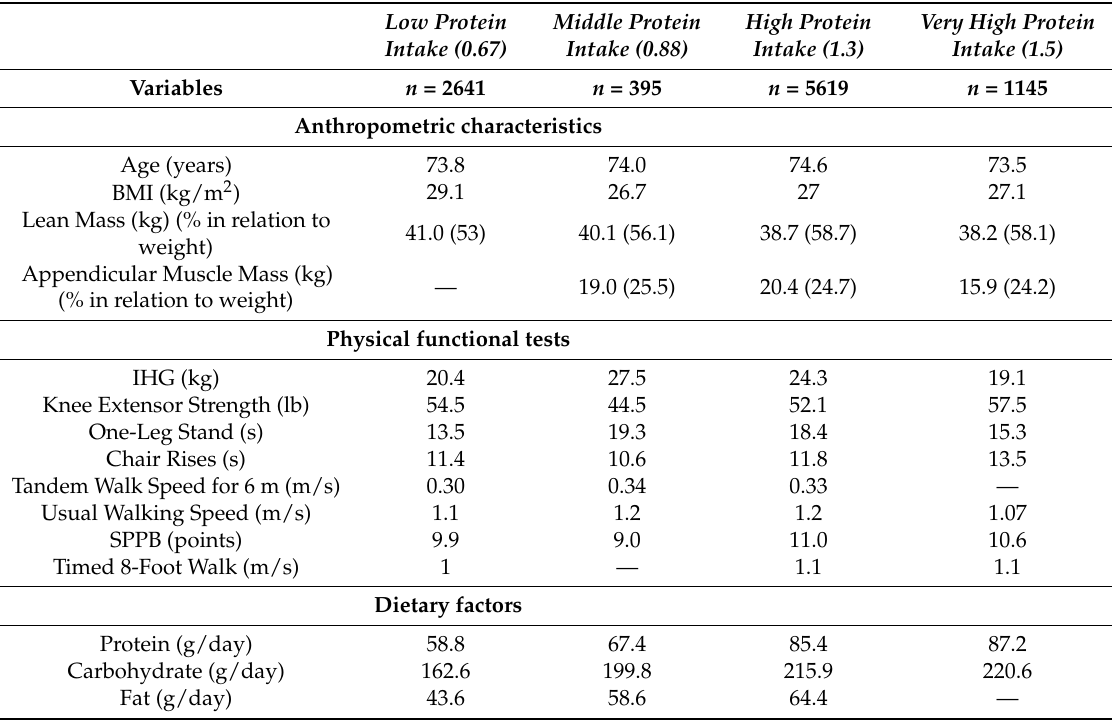
Table 2. Characteristics of the volunteers according to relative protein intake